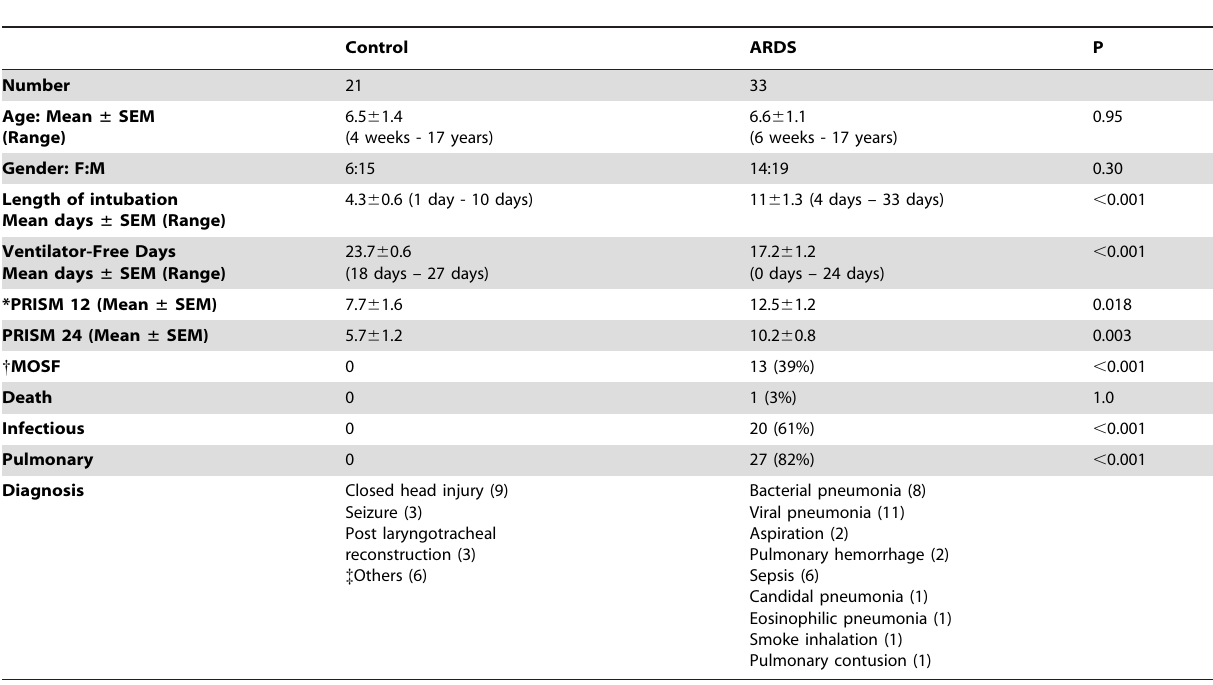
Table 1. Demographic and diagnostic information of ARDS and control